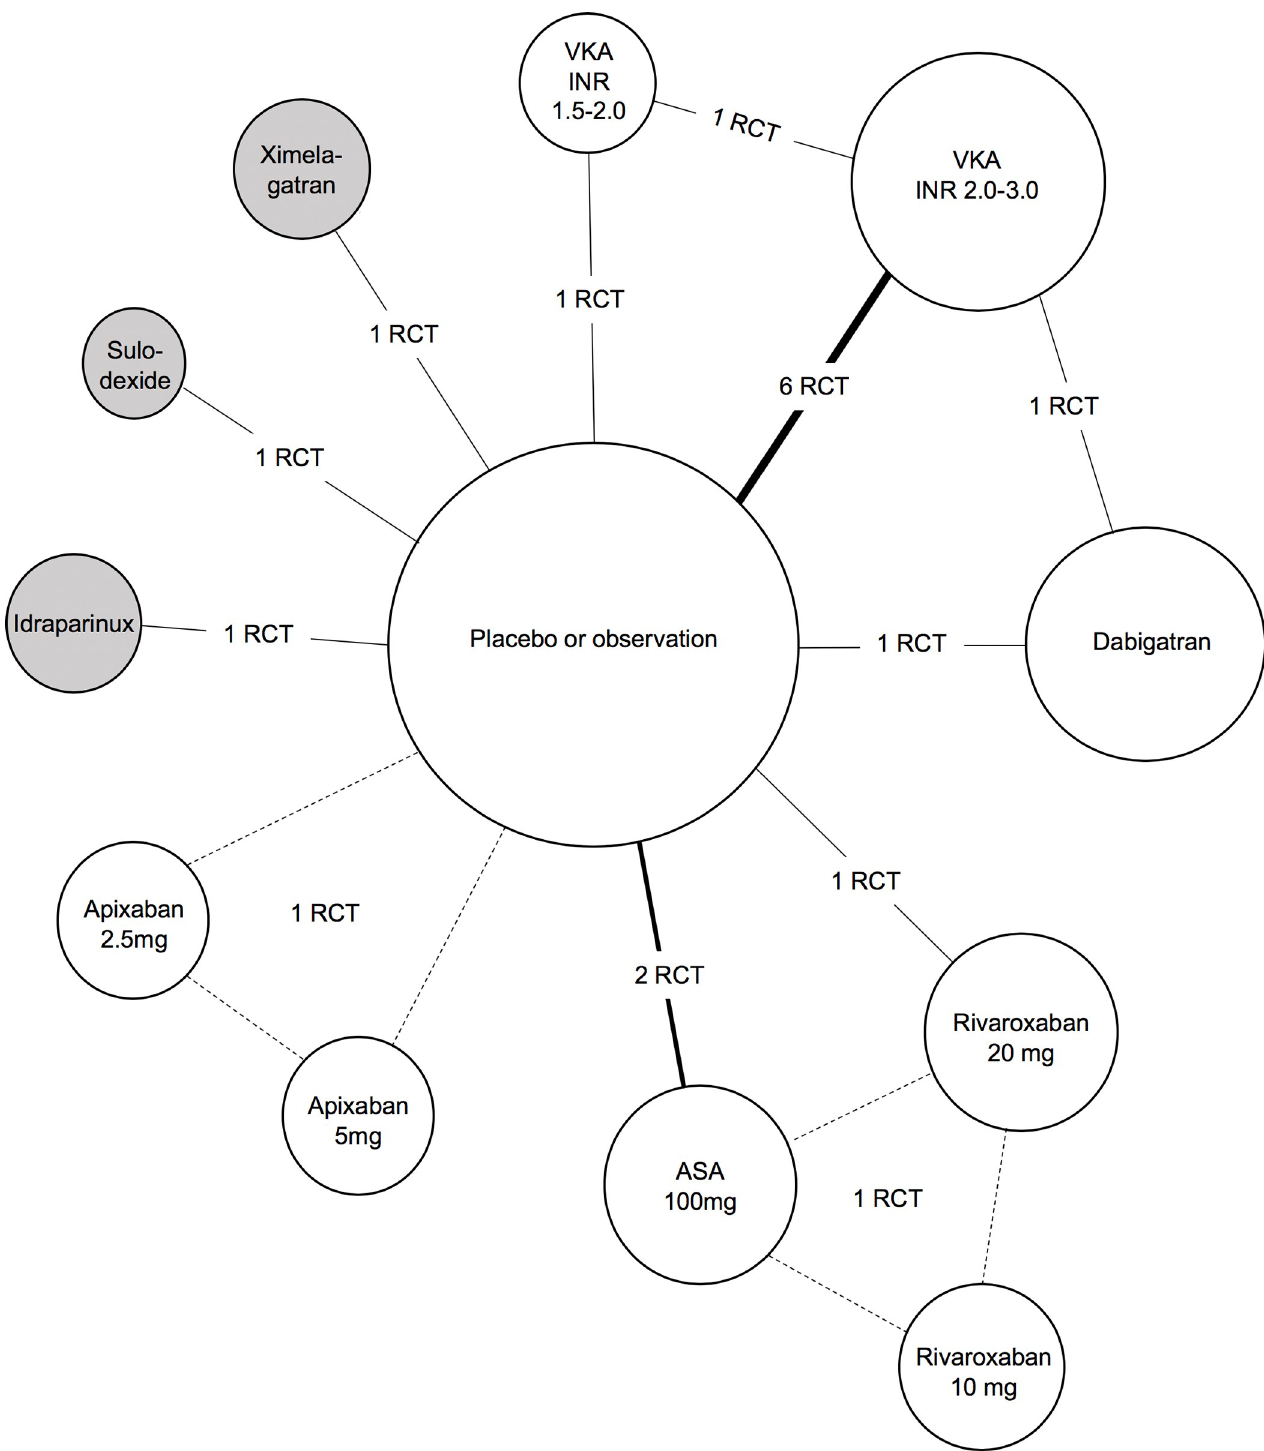
Fig 2. Evidence network of included studies. The width of lines for each connection in the evidence network are proportional to the number of randomized controlled trials (RCTs) comparing each pair of treatments. Multiarm trials are represented in dotted lines. The size of each treatment node is proportional to the number of randomized participants (sample size). Direct oral anticoagulants for the main analysis included apixaban, dabigatran and rivaroxaban, whereas unmarketed drugs (shaded in gray) ( idraparinux, sulodexide and ximelagatran) were used for sensitivity analyses only (see online supplement). ASA: aspirin; RCT: randomized controlled trial; VKA: vitamin K